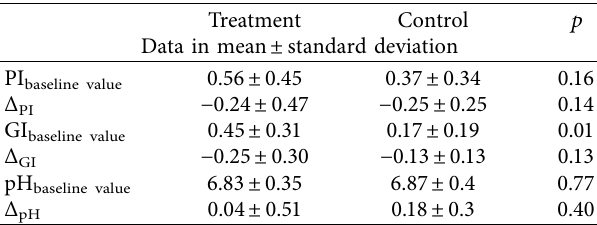
Table 2: Plaque index, gingival index, and potential hydrogen of the treatment group ( n � 19) and the control group ( n � 19).